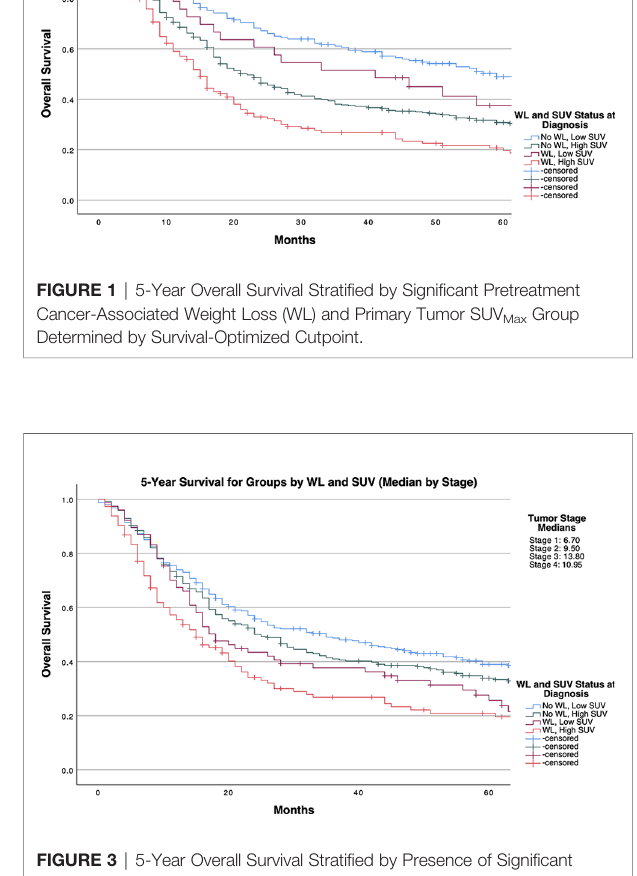
FIGURE 3 | 5-Year Overall Survival Strati fi ed by Presence of Signi fi cant Pretreatment Cancer-Associated Weight Loss (WL) and Primary Tumor SUV Max Group Determined by Stage-Speci fi c